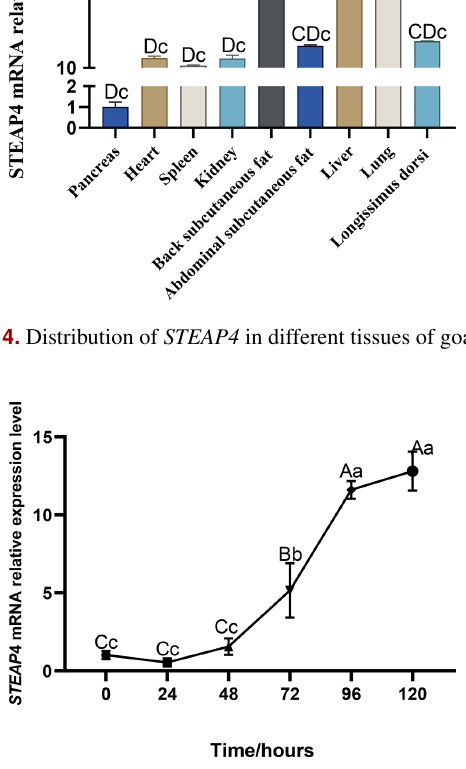
Figure 5. Cell temporal expression profile of STEAP4 in goat sub- cutaneous